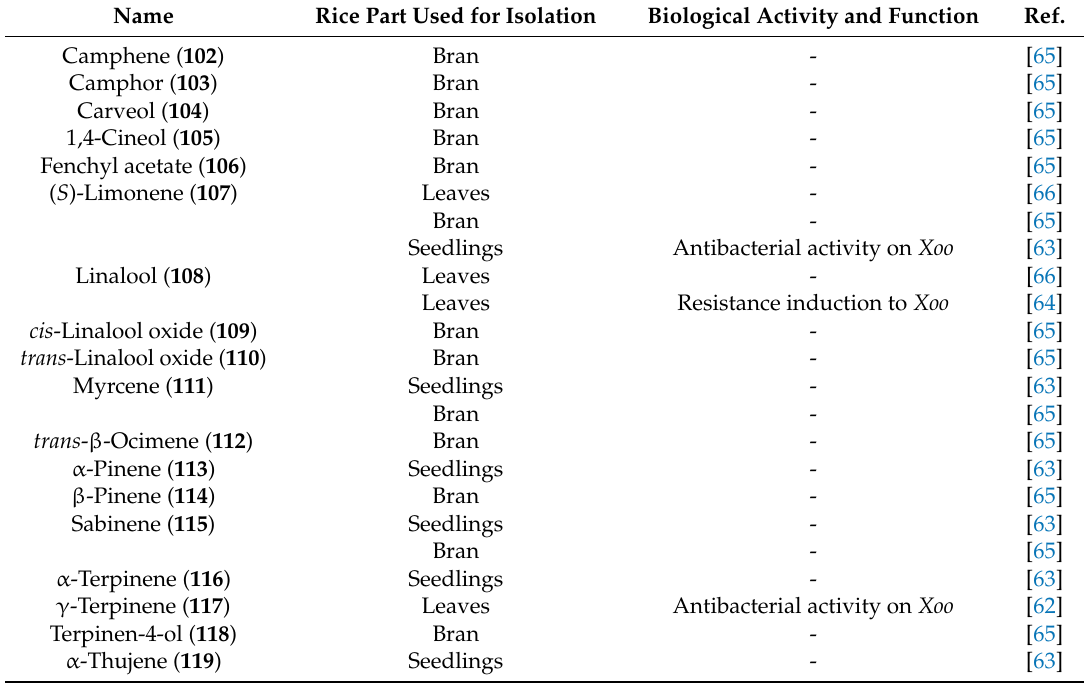
Table 3. Monoterpenoids and their biological